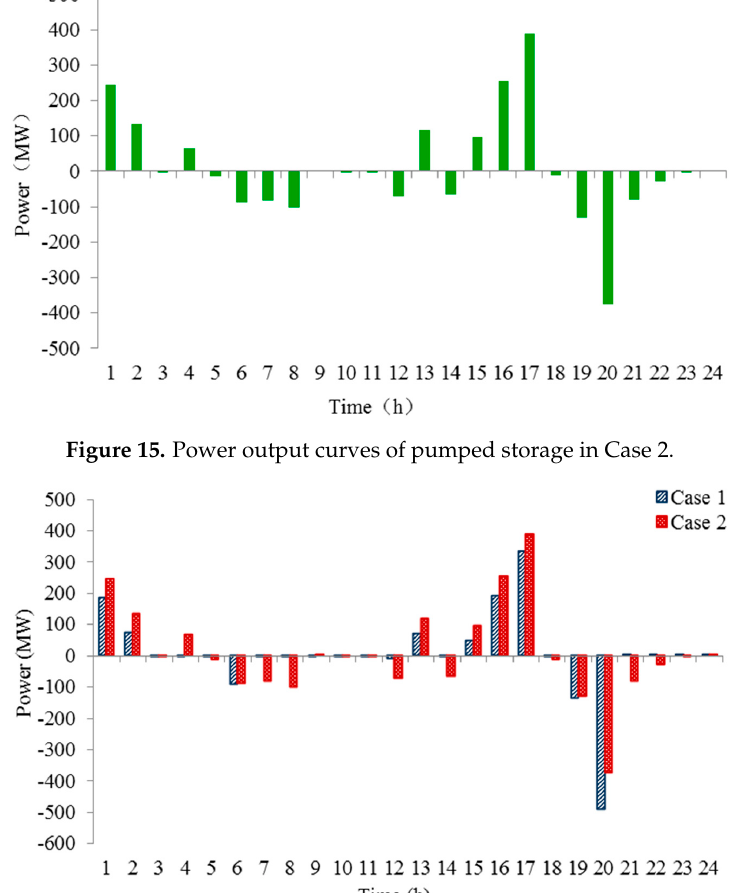
Figure 17. Power output curves of thermal generators in Case 3.